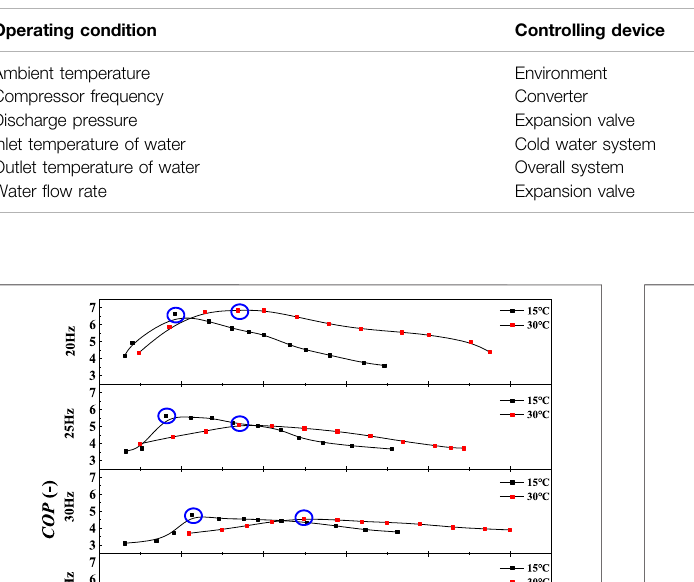
TABLE 3 | Speci fi c operating condition.